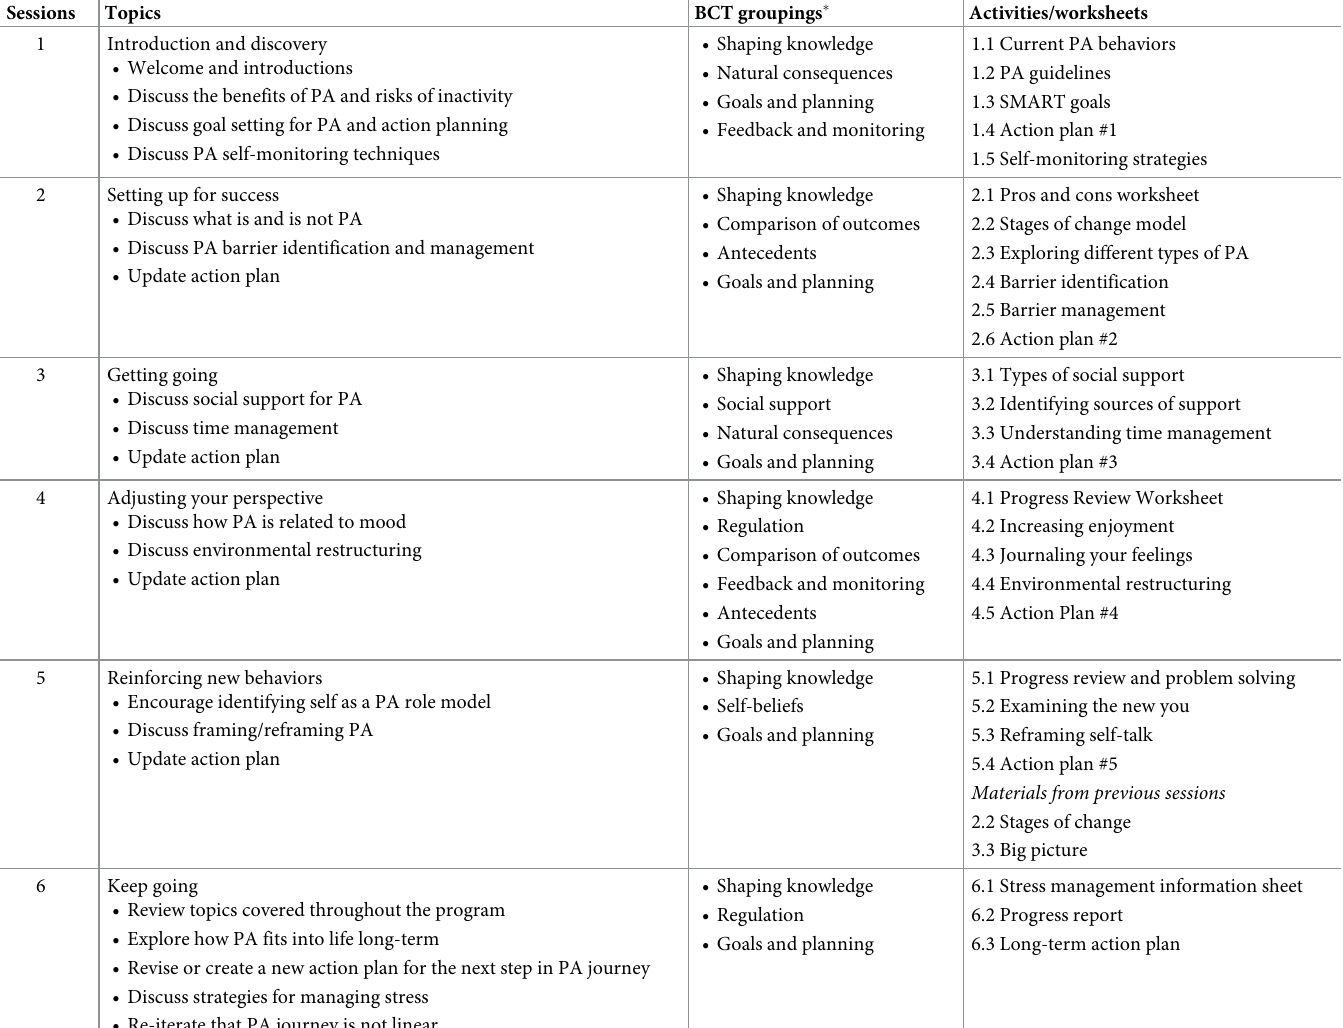
Table 2. ACCESS intervention session topics and